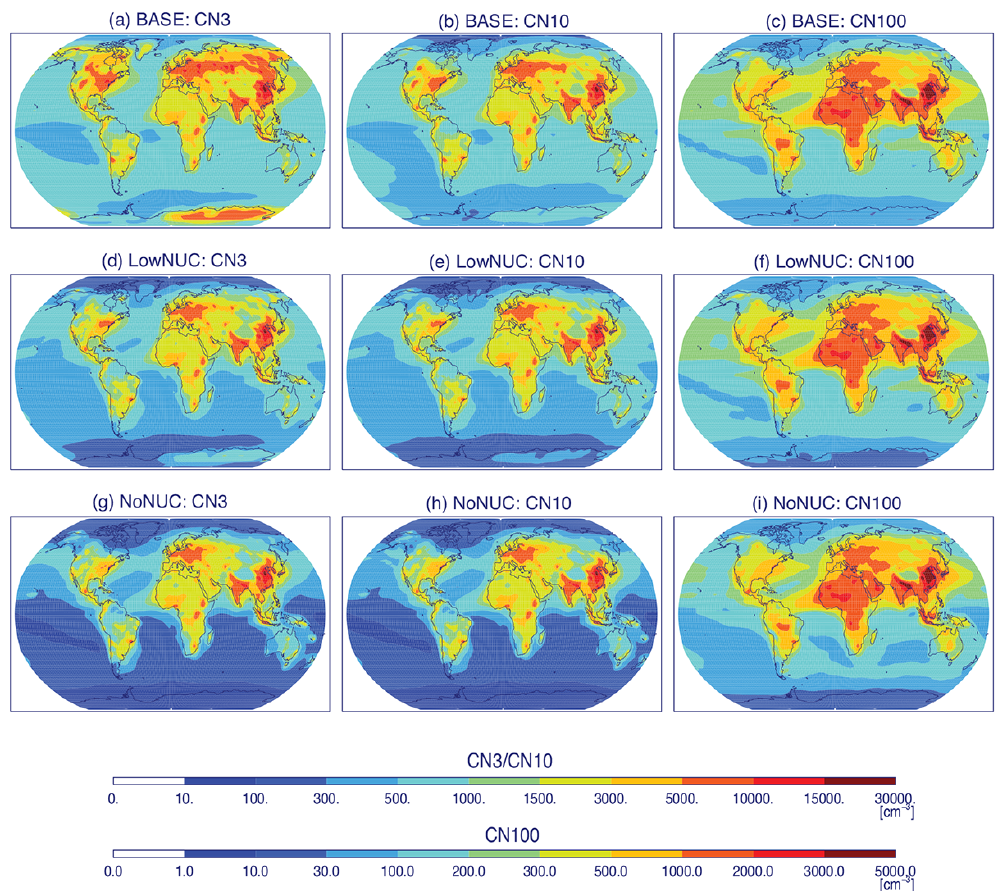
Figure 19. Annually averaged CN 3 (Dp ≥ 3nm), CN 10 (Dp ≥ 10nm), and CN 100 (Dp ≥ 100nm) concentrations in the lowermost layer for the BASE run ( a to c ), the LowNUC run ( d to f ), and the NoNUC run ( g to i ) of ModelE2-TOMAS. Units are cm − 3